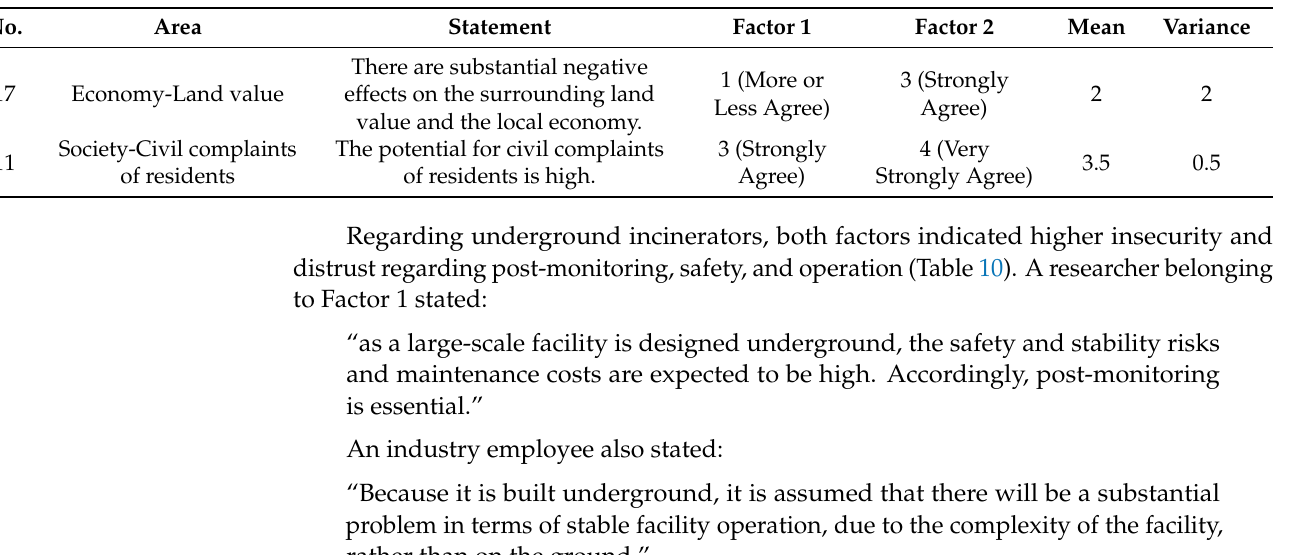
Table 9. Consensus statements regarding ground incinerators.